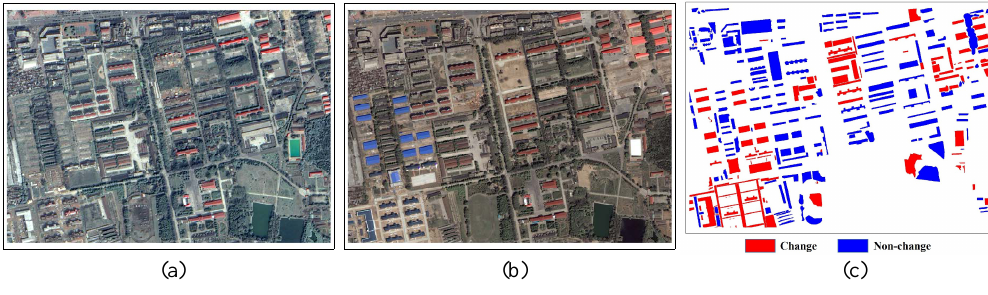
Figure 2. Experimental Area A. ( a ) Image acquired on 15 September 2004; ( b ) image acquired on 2 May 2005; ( c ) standard reference change